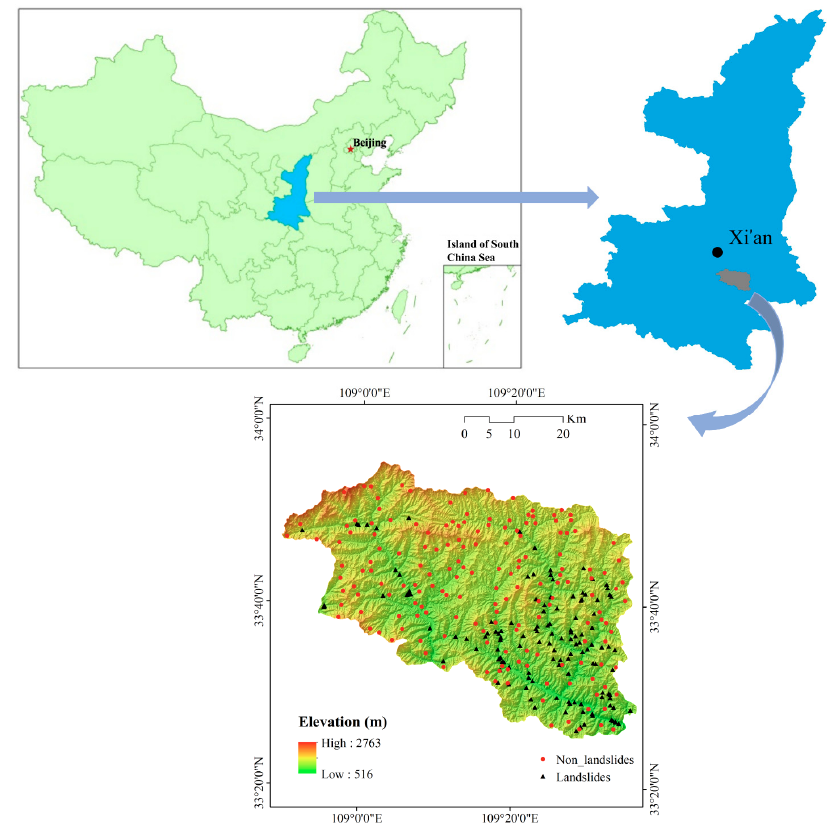
Figure 1. Location of the study area.